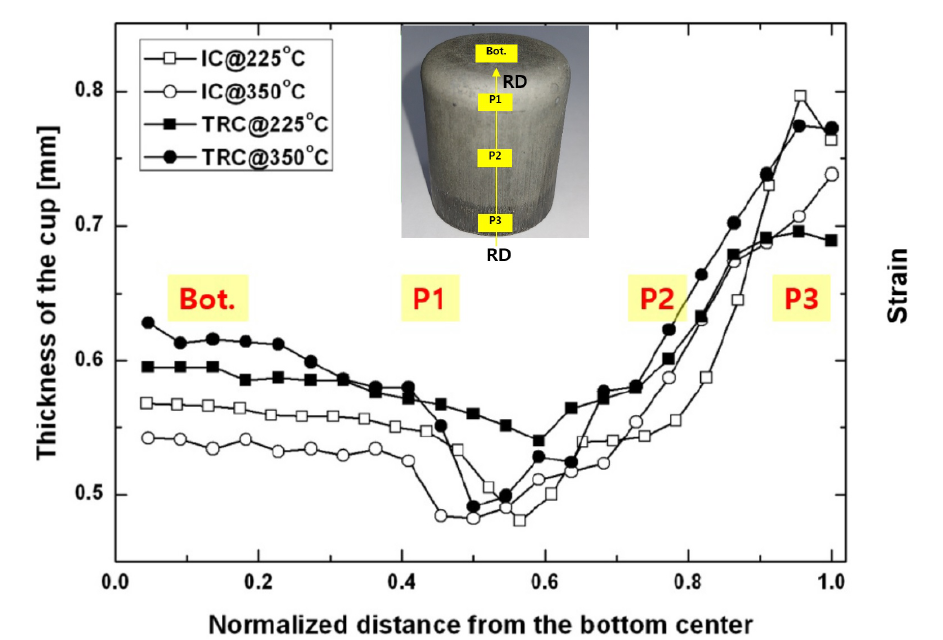
Figure 7. Variations of thickness during deep